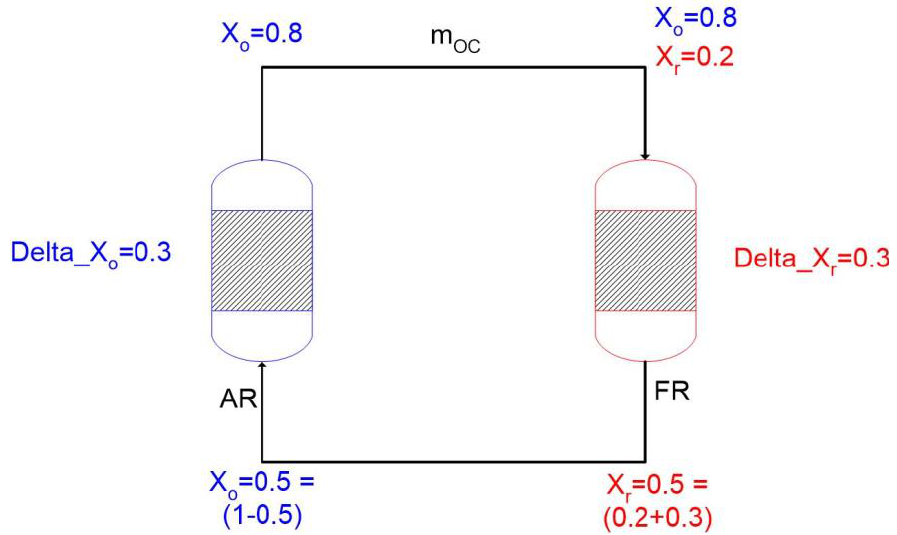
Figure 4. Oxygen carrier conversion rate in the air and fuel reactor, assumed values .